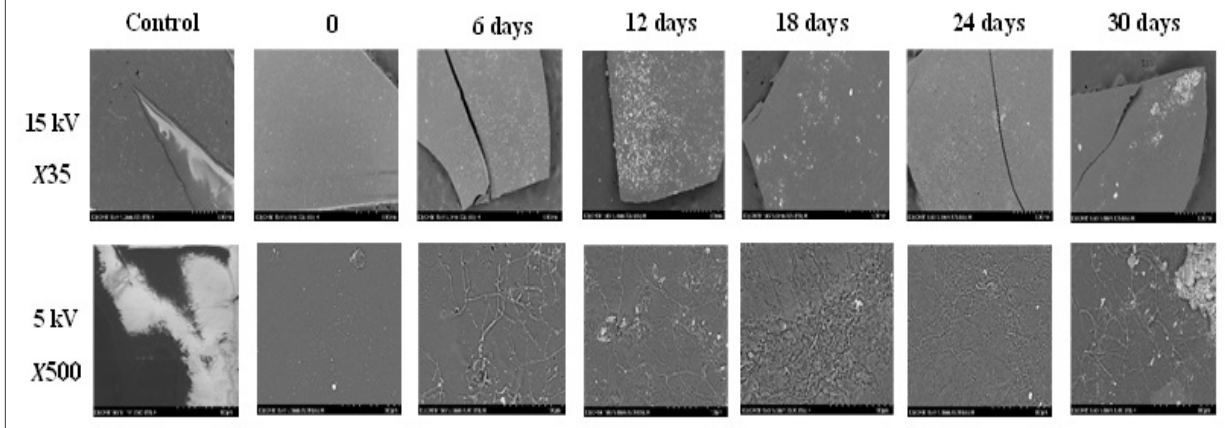
Figure 7. The surface morphology for CSH film samples and control sample (Polyethylene film) before and during the soil burial test.